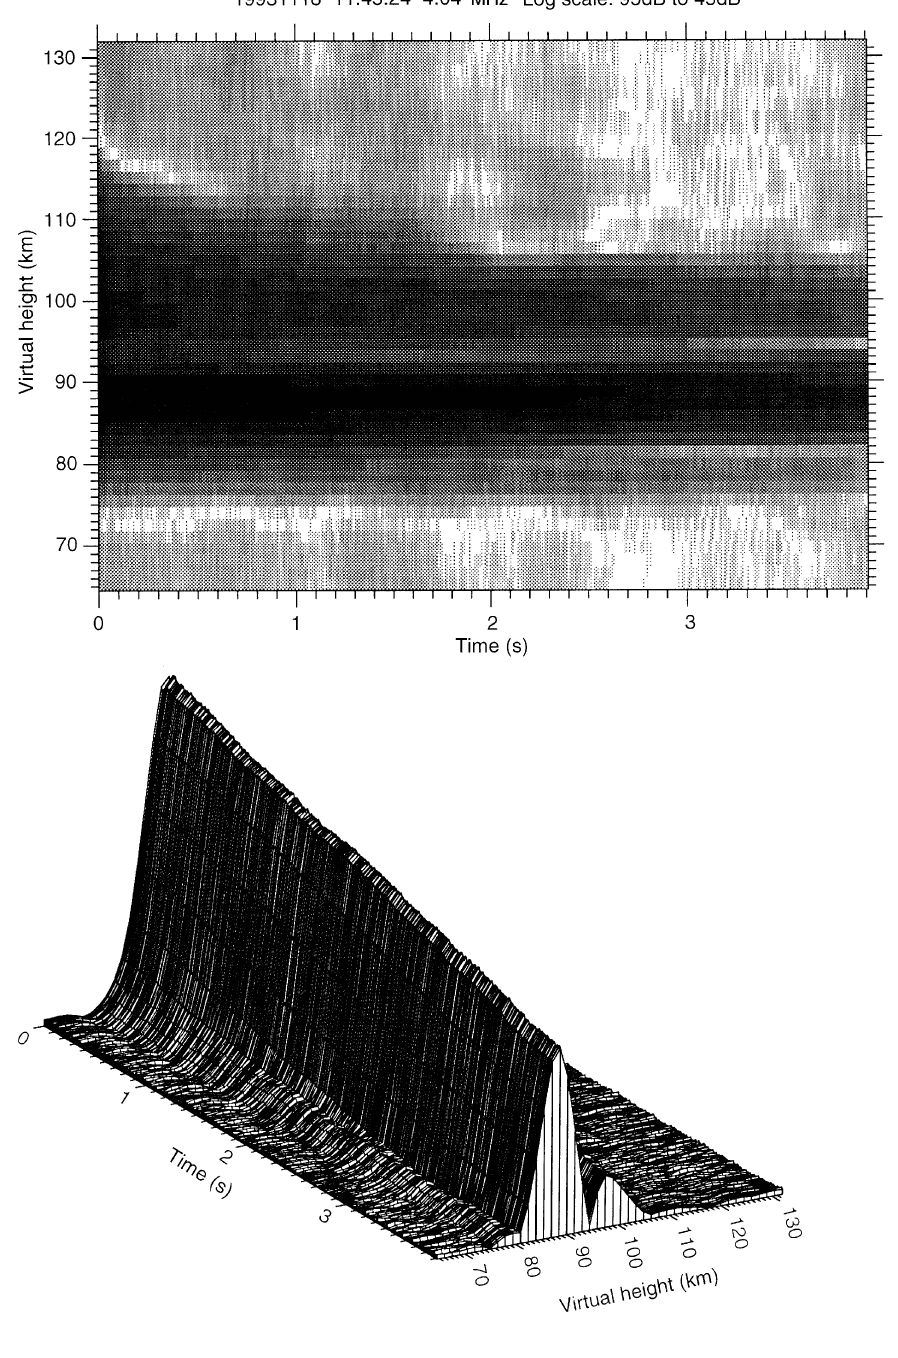
Fig. 4. A profile of API echo amplitude and phase fits from the echoes in Fig. 3. The time-constant ( „ (cid:99) ) of the exponential decay of the form Ae (cid:126) (cid:116) (cid:64) (cid:84) (cid:99) # C which is fitted to the amplitude data together with the reduced chi-square value of the fit is indicated on each plot in the left - hand column , and the vertical velocity (Vel) derived from the linear fit to the phase is indicated together with the reduced chi-square value in each plot in the right - hand column . Positive velocities are upwards. The data from 70.5 km are shown to indicate the